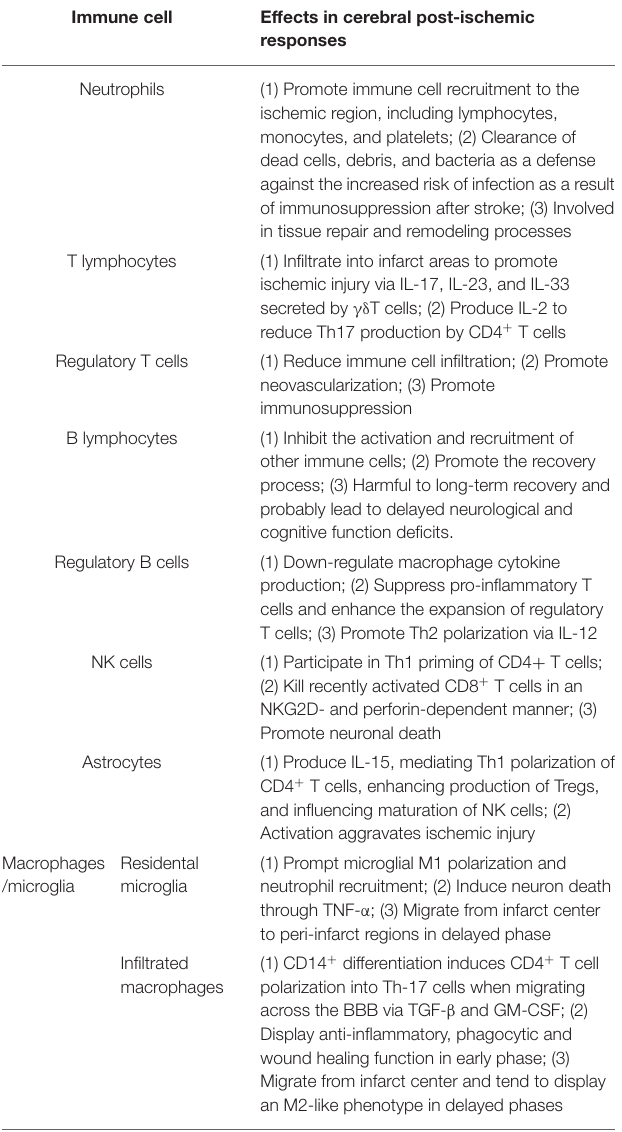
TABLE 1 | Effects of immune cells in immune responses after cerebral ischemia. Immune cell Effects in cerebral post-ischemic